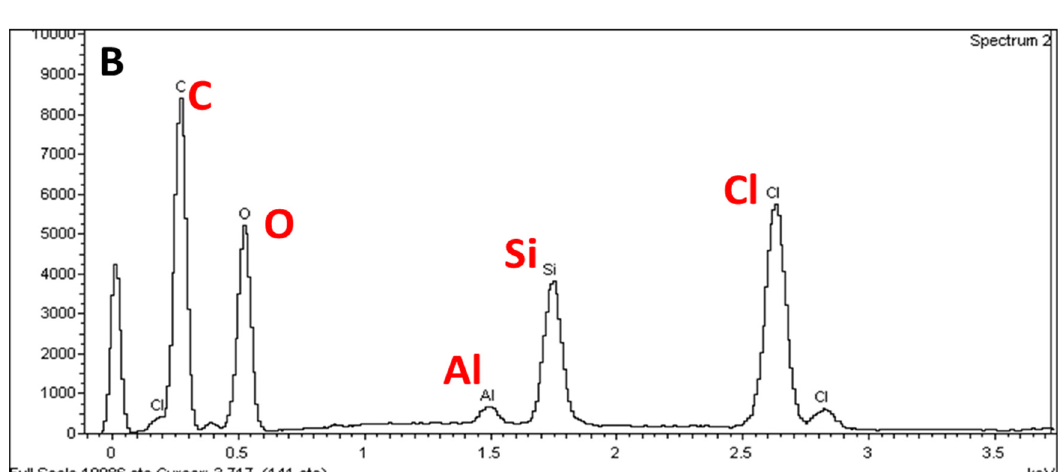
Figure 2. The elemental compositions of the S1 and S2 electrodes showing the percentage of carbon (C), oxygen (O), aluminum (Al), silicon (Si) and chlorine (Cl) which were determined from EDX C